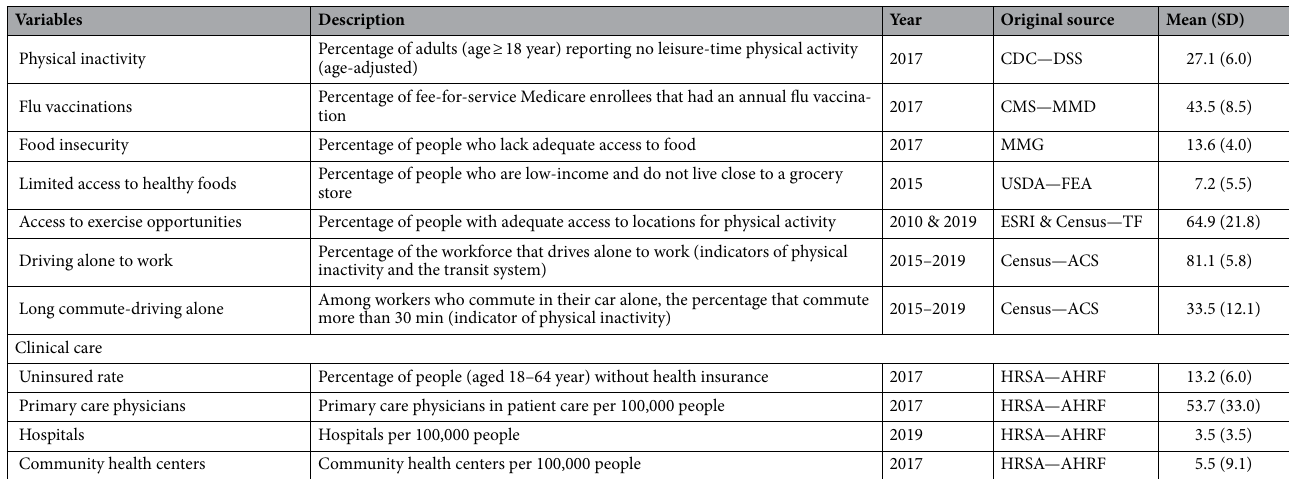
Table 1. Definition and summary statistics of risk factors in the study. Variables obtained from AHRF: all variables under Clinical Care, Receipt of SNAP benefits, Median Household Income, Poverty, Under 200% poverty; Variables obtained from EPA-EJSCREEN: all variables under Environmental Exposure; Variables obtained from CHR: all other variables. AHRF area health resources files, BLS bureau of labor statistics, BRFSS behavioral risk factor surveillance system, CBP county business patterns, CDC centers for disease control and prevention, CHAS comprehensive housing affordability strategy, CHF county health rankings & roadmaps, CMS centers for medicare & medicaid services, DSS US diabetes surveillance system, EJSCREEN environmental justice screening tool, EPA environmental protection agency, FEA food environment atlas, HRSA health resources and services administration, MMD mapping medicare disparities (MMD) tool, MMG map the meal gap, NCHHSTP national center for HIV/AIDS, viral hepatitis, STD, and TB prevention, NCHS national center for health statistics, NLP national priorities list, PE population estimates, PM fine particulate matter, RMP risk management plan, SNAP supplemental nutrition assistance program, TF tigerline files, USDA US department of